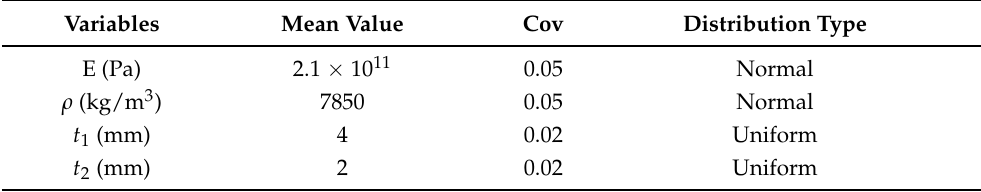
Table 1. Characteristics of random